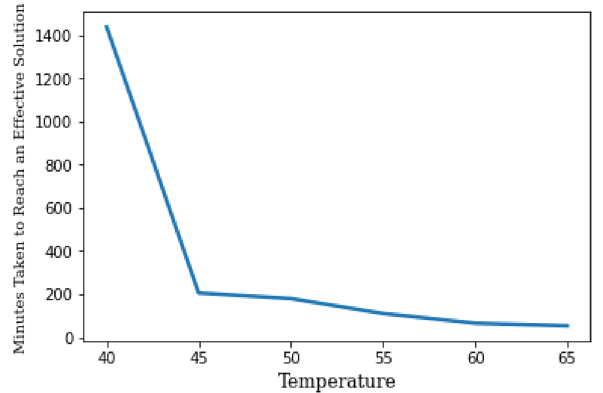
Figure 2. The logarithmic effect of the temperature on the pace of reaching an effective solution.